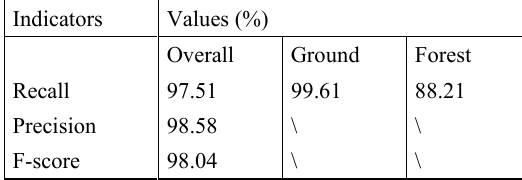
Table 3 . Filtering indicators of ATL03